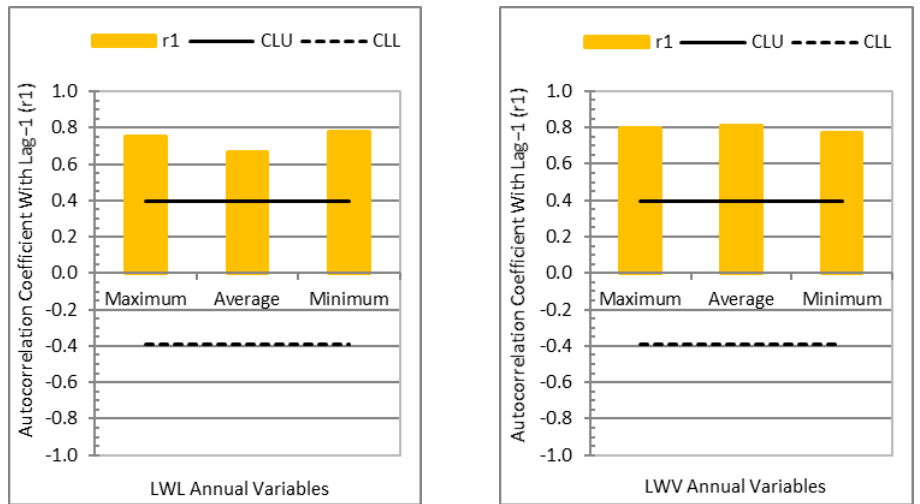
Figure 6. Lagged-1 autocorrelation coefficients of the de-trended LWL and LWV series. CLU = upper confidence limit; CLL = lower confidence